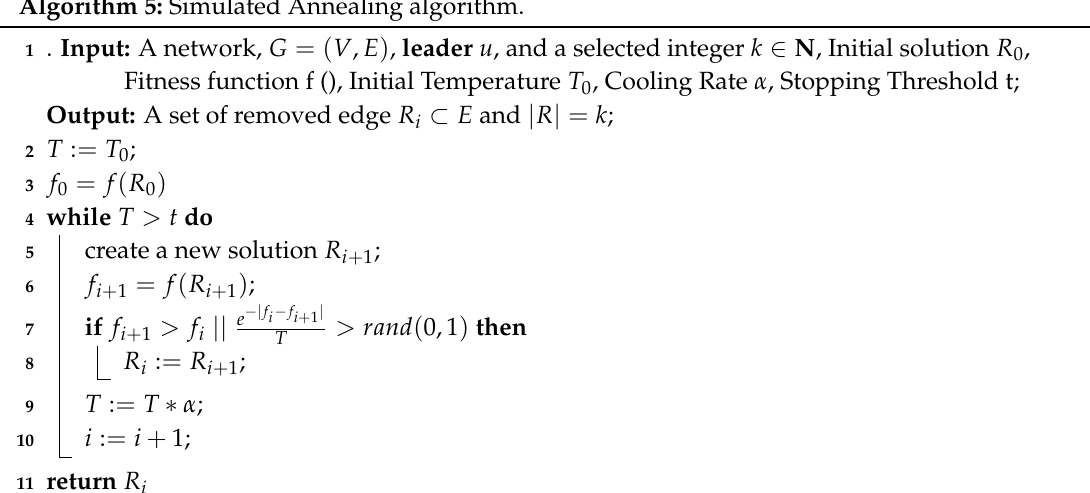
Algorithm 5: Simulated Annealing